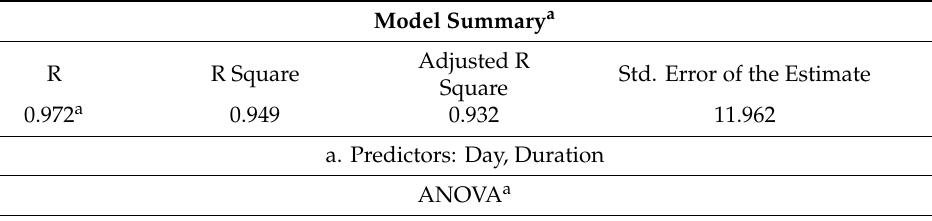
Table 9. Analysis results of disaster-prevention rainfall equation for urban areas using multiple regression